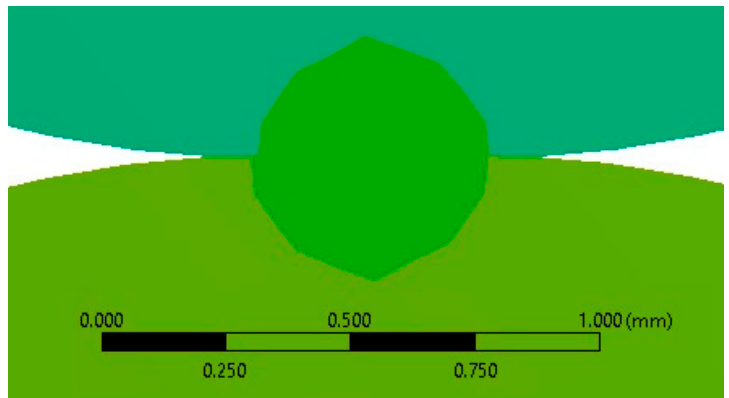
Figure 14. Close-up to the contact area between two bodies analyzed with FEM.